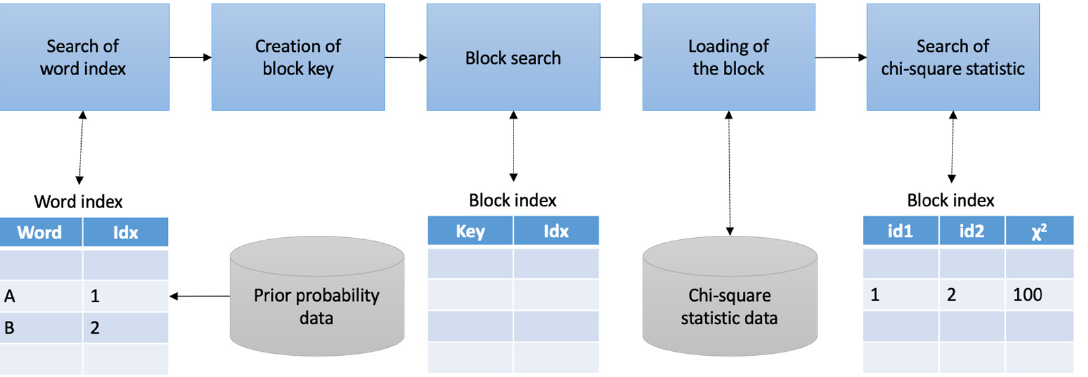
Figure 9. Chi-square statistic and prior probability search method.